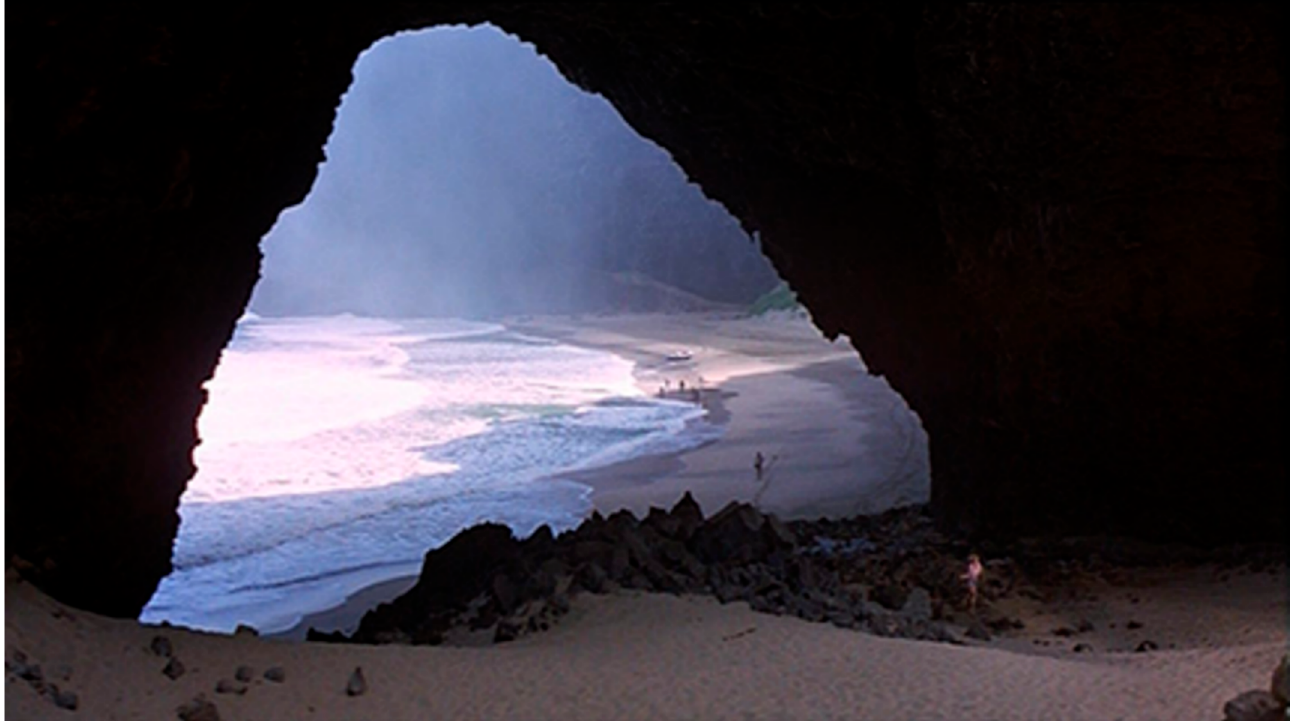
Figure 9. Triangular door of Skull Island. The female protagonist is the first to pass through (1976). http://www.mundodvd.com/king-kong-1976-a-138063/ (accessed on 1 January 2021).